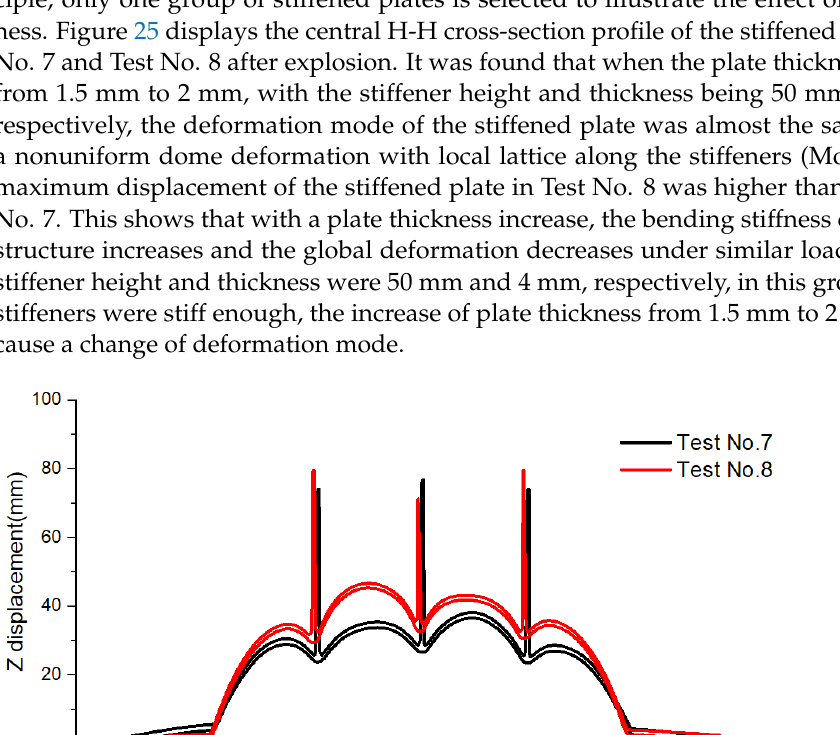
Figure 24. Central H-H section profile of Tests No. 2, 4, and 5.